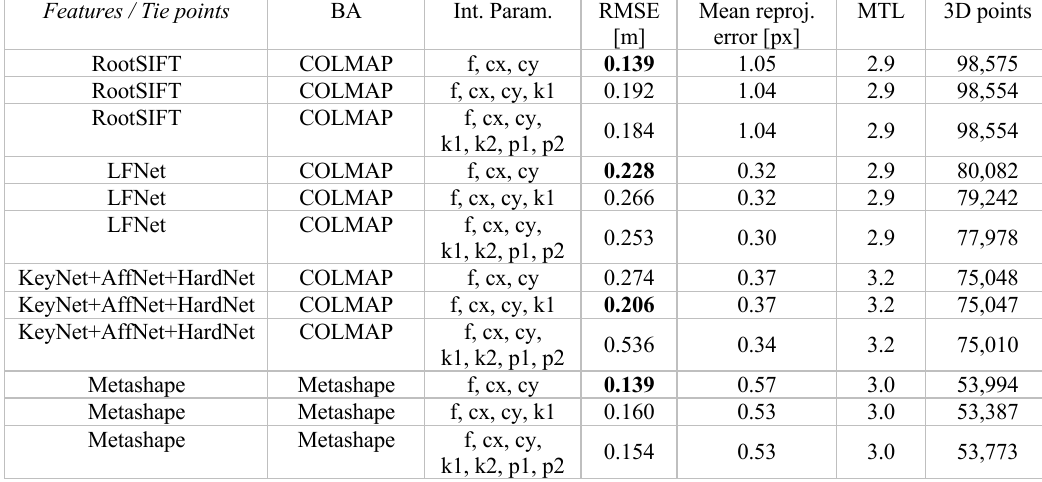
Table 2: AT results for the Dortmund dataset.